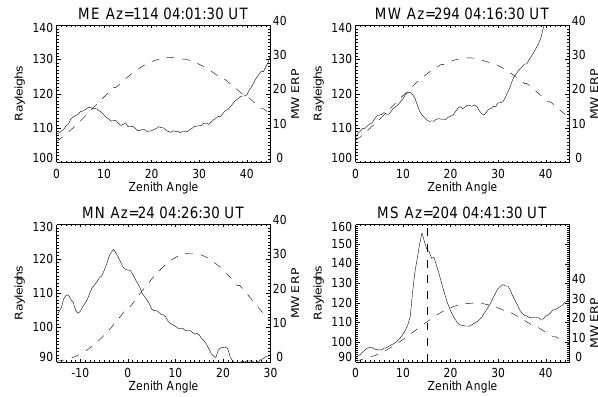
Fig. 2. Line profiles of 630nm emission intensity (solid) and HAARP beam ERP (dashed) for the images shown in Fig. 1. Pro- files are along the cardinal magnetic directions in the geographic azimuths as indicated at the top of each panel. Increases in intensity beyond 30 ◦ zenith angle are due to the natural sky